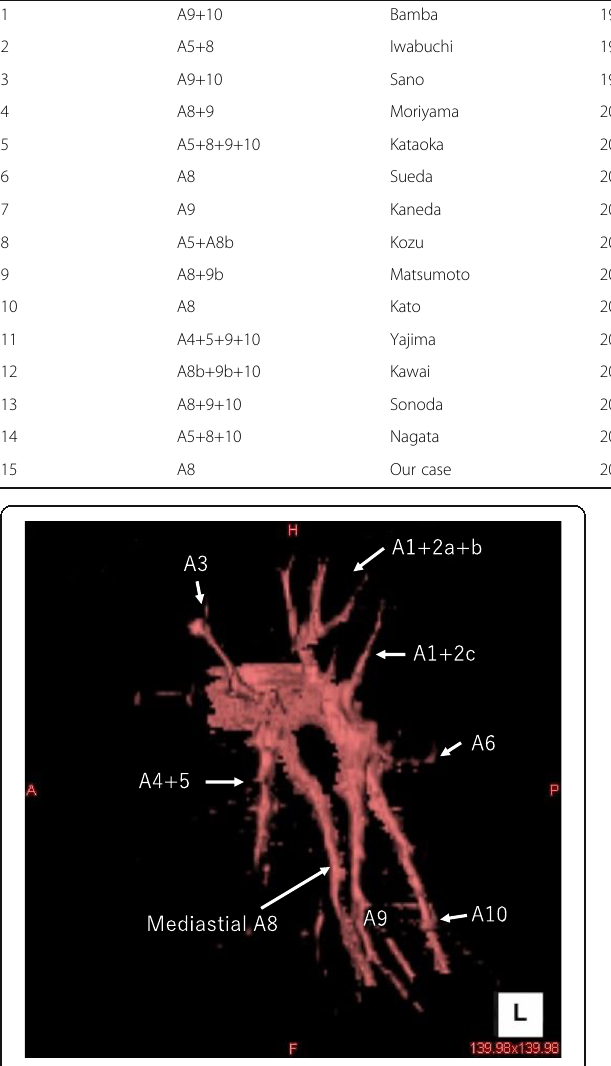
Fig. 5 Three-dimensional computed tomographic pulmonary angiography of our case without contrast medium. It was constructed by non-contrast CT retrospectively. It is easy to recognize left